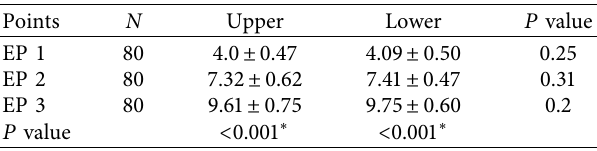
Table 4: Alveolar bone width (mm) of upper and lower jaws at edentulous